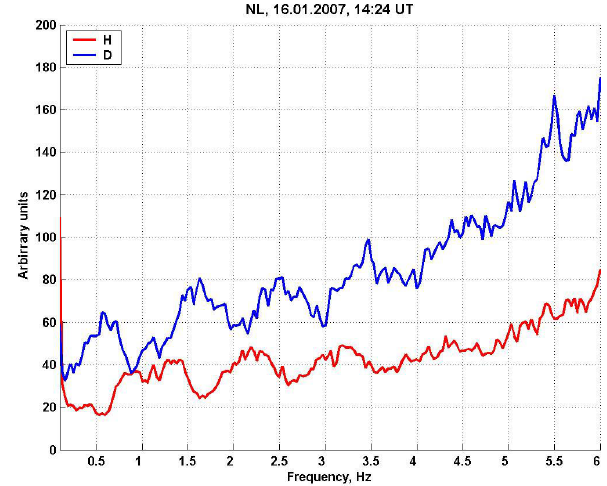
at NL at the given date and time. Averages over successive, non- redundant, 512 point FFTs were used to get an integration over ∼ 10min. The general increase of the power spectral density over frequency reflects the increase of sensitivity of the search coil mag- netometer (raw